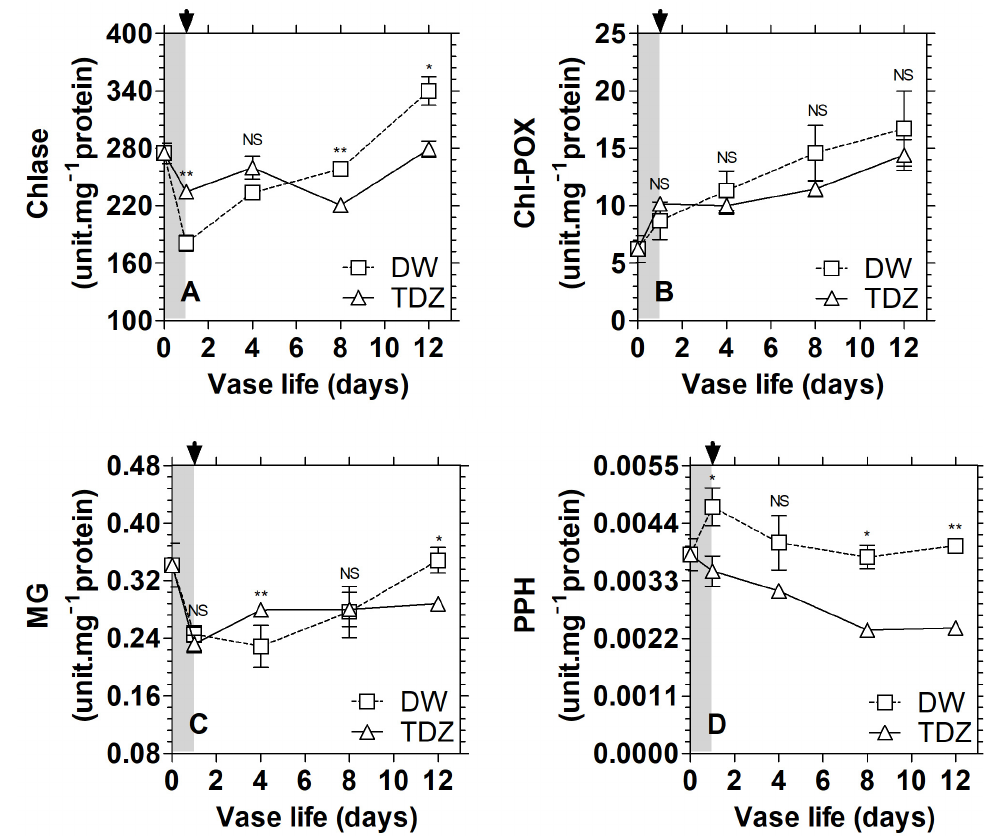
Figure 10. Effect of TDZ and MAP on activities of Chl catabolism enzymes; chlorophyllase; Chlase ( A ), chlorophyll peroxidase; Chl-POX ( B ), magnesium dechelatase; MG ( C ) and pheophytinese; PPH ( D ) in D. solida leaves after 1-week storage. Leaves were pulsed with 10 µ M TDZ and distilled water (DW; control), then packed in BOPP bag, and stored at 10 °C under cool-white fluorescent lights for 12 h/d for 1 week. After storage, ferns were transferred to distilled water in a controlled environment room for the vase period. Asterisks (*) indicate significant differences between the two treatments after storage ( t -test; * p < 0.05, ** p < 0.01, ns not significant). The black arrow indicates the initial day in the vase.